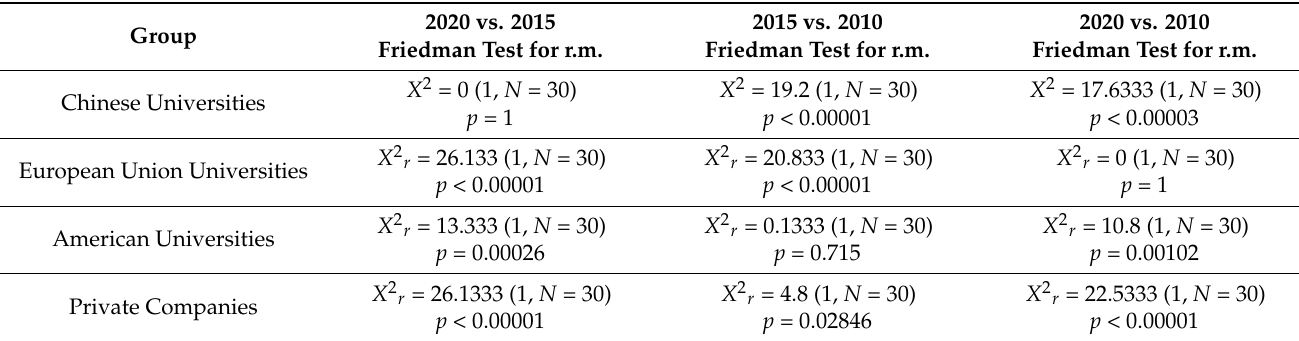
Table 6. Trends within groups over time (Friedman test for repeated measures) in sub indicator “Innovation” in the best 30 universities of China, the European Union, the US, and in private companies. Group